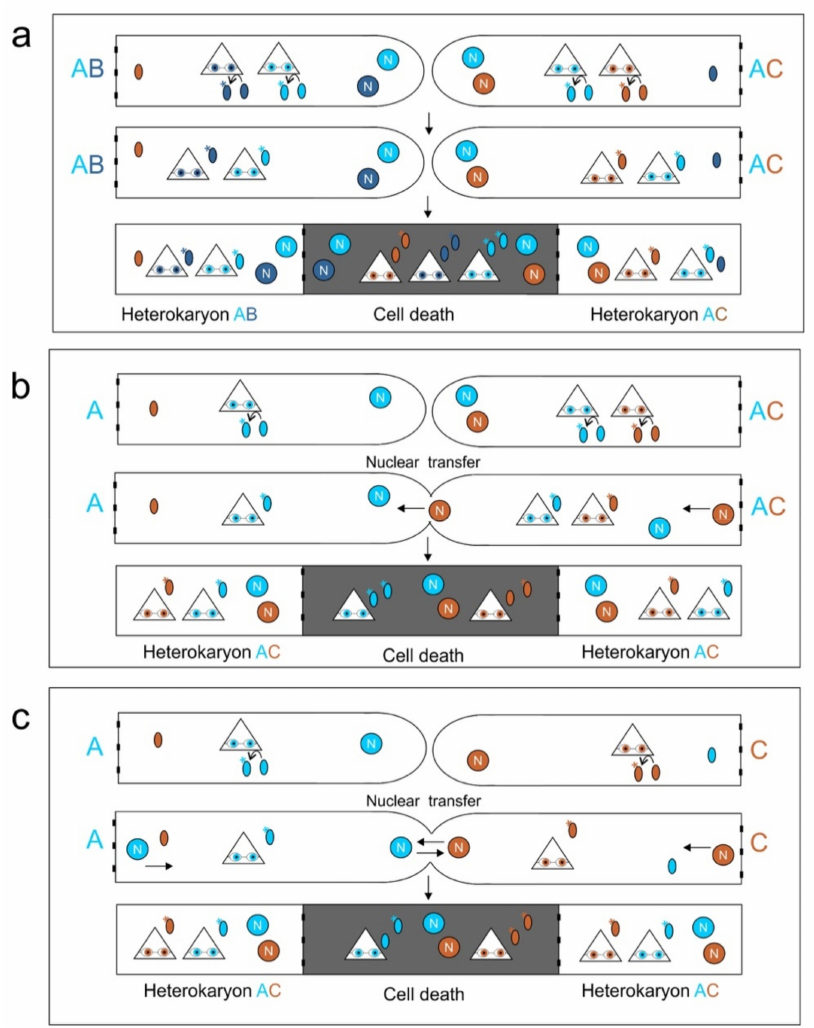
Figure 3. A basidiomycete scenario for a reader/writer involvement in nonself recognition. ( a ) inter- actions between heterokaryons. Each nucleus (circle with letter N) produces a reader/writer (triangle with glasses) that both modifies (asterisks) its target (oval), as well as monitors for the presence of an unmodified target. Each nucleus of each heterokaryon modifies its own target, but each